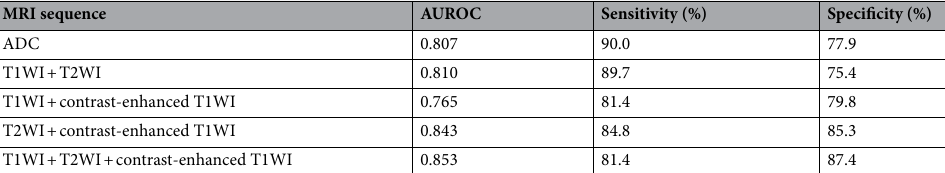
Table 3. Diagnostic performance of radiomics features to discern occult palatine tonsil SCC from normal palatine tonsils according to a combination of MRI sequences. ADC apparent diffusion coefficient; AUROC